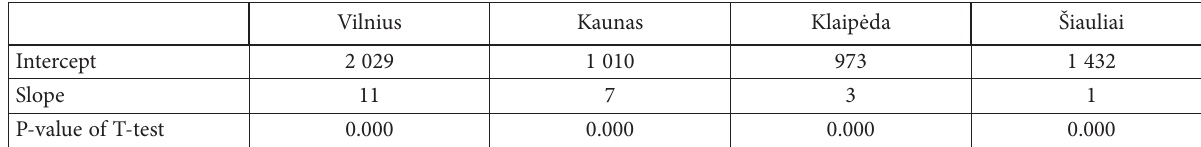
Table 4. Coefficients of a simple linear regression between the number of newcomers and monthly wage